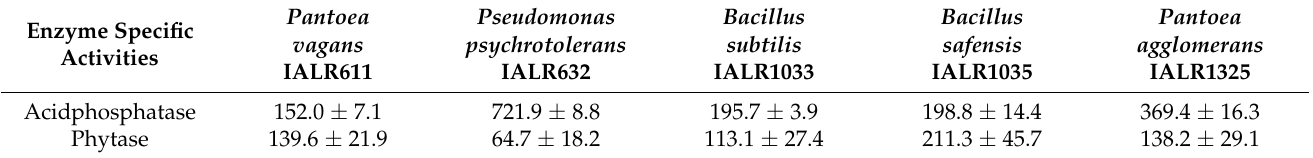
Table 3. Acid phosphatase and phytase activities produced by bacterial